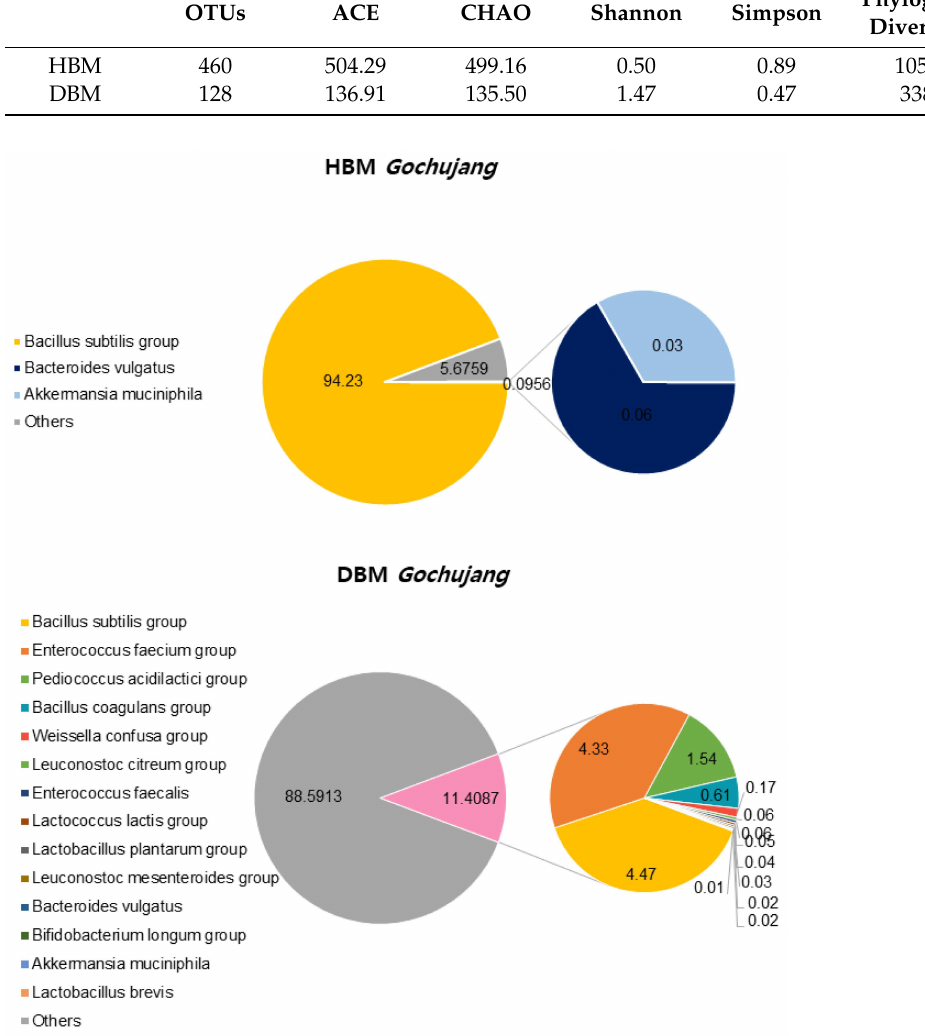
Figure 1. Beneficial bacteria composition of HBM and DBM Gochujang